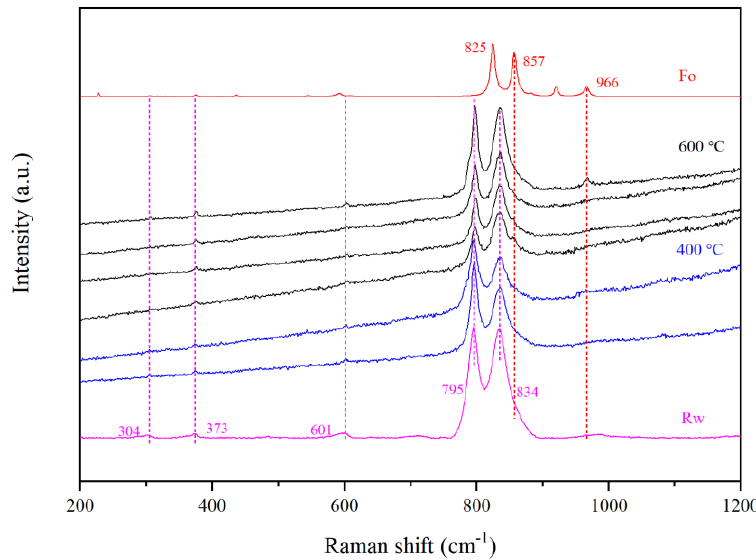
Figure 11. Multiple Raman spectra taken on two Mg-Rw crystal plates after finishing the annealing experiments (respectively, at 400 and 600 °C) and the IR measurements. For the purpose of comparison, the Raman spectra of forsterite (Fo) [10] and Mg-Rw (http://rruff.info) are displayed. The evolutions of the water contents for the intermediate-H 2 O Mg-Rw thin sections annealed at